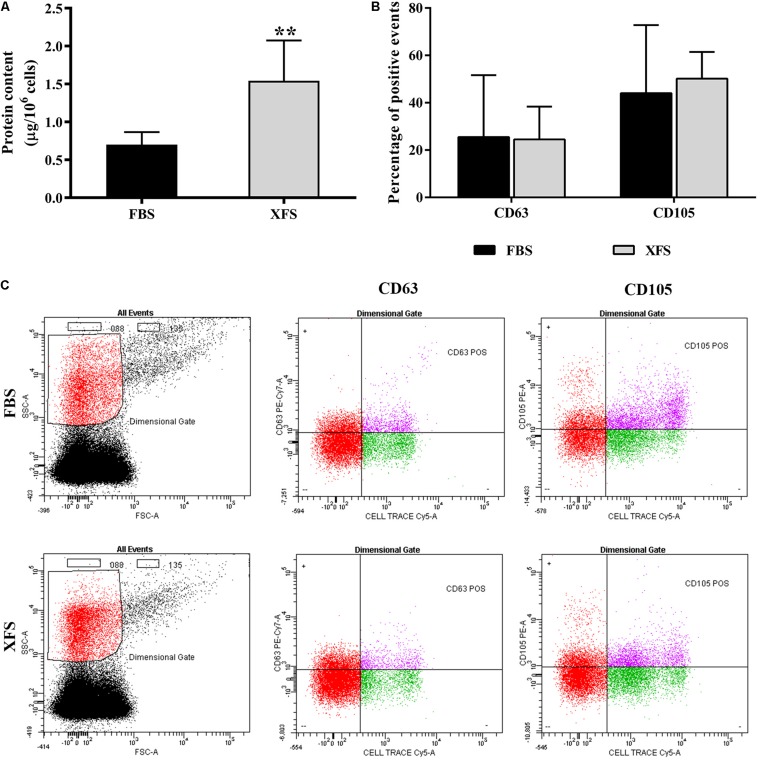
Characterization of EVs derived from hBMSC cultured in FBS- or XFS-containing medium. (A) BCA assay of the protein concentration of FBS- and XFS-hBMSC-EVs released by 106 cells. Data are shown as mean ± SD, **P < 0.01, t-test and are representative of six independent experiments. (B) Histogram showing the percentage of Cell Trace-positive EVs expressing CD63 or CD105. Data are shown as mean ± SD and are representative of three independent experiments. (C) Flow cytometry to characterize FBS- and XFS-hBMSC-EVs. Vesicles were stained by the lipophilic dye Cell Trace and specific antibodies against the vesicular marker CD63 or the MSC marker CD105. The left panel shows the physical parameters of samples. The black dots represent the noise and the red ones the dimensional gate, set on the size of reference beads. The right panels show the percentage of Cell-Trace+-CD63+ or Cell-Trace+-CD105+ events inside the dimensional gate (pink dots are double positive events).